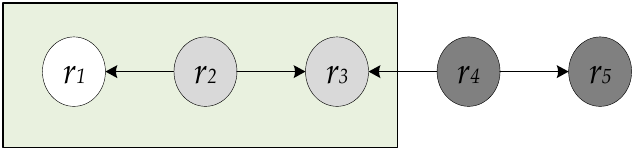
Figure 1. An example of reachable resources in Linked Data Semantic Distance (LDSD).